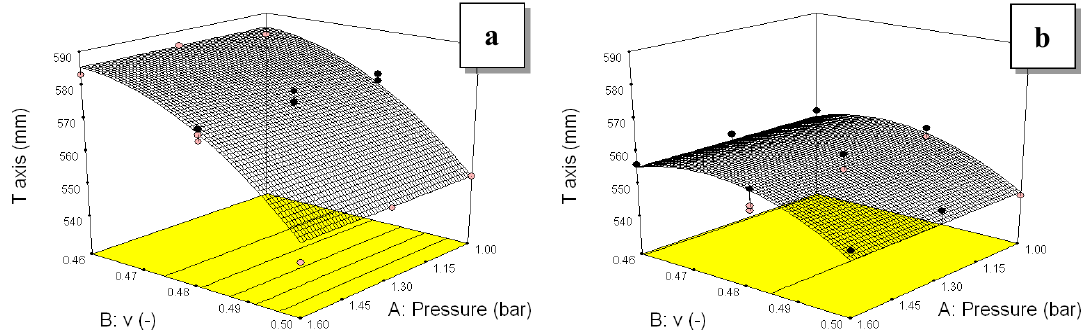
Figure 13. 3D representation of the interpolation models for the footprint transversal axis of the two tested tyres ( a : 420 / 85 R24; b : 460 / 85 R34) as a function of Poisson’s ratio and the tyre-inflating pressure.